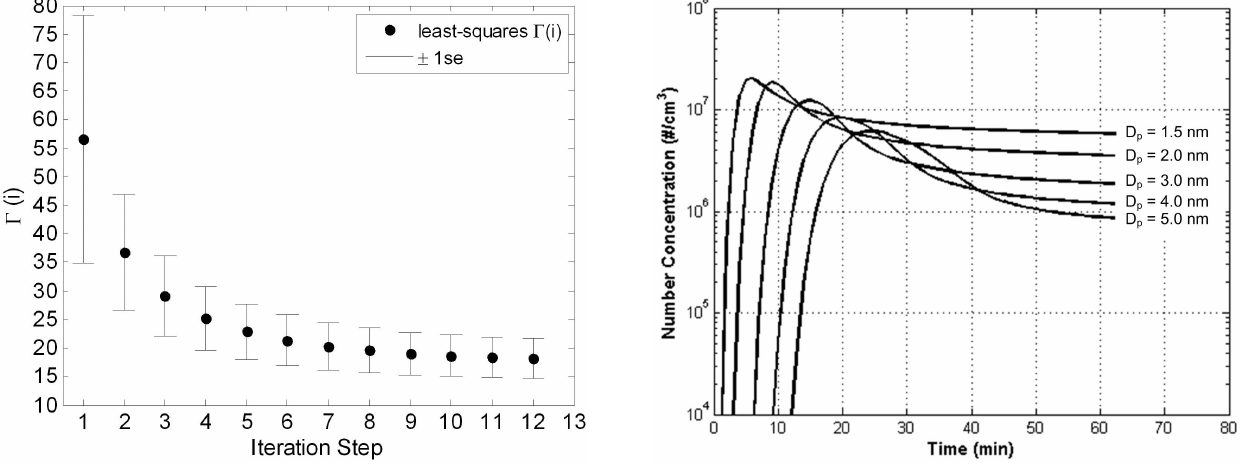
Fig. A3. Time-dependent particle number concentrations at various particle geometric diameters D p for collision-controlled nucleation in the free-molecular regime for a system that is initially particle- free. For particles smaller than 5nm, less than an hour is needed to reach a quasi-steady state. After quasi-steady state is reached, the decrease in number concentration is due to the increase of aerosol surface area (a coagulation sink), and does not depend explicitly on